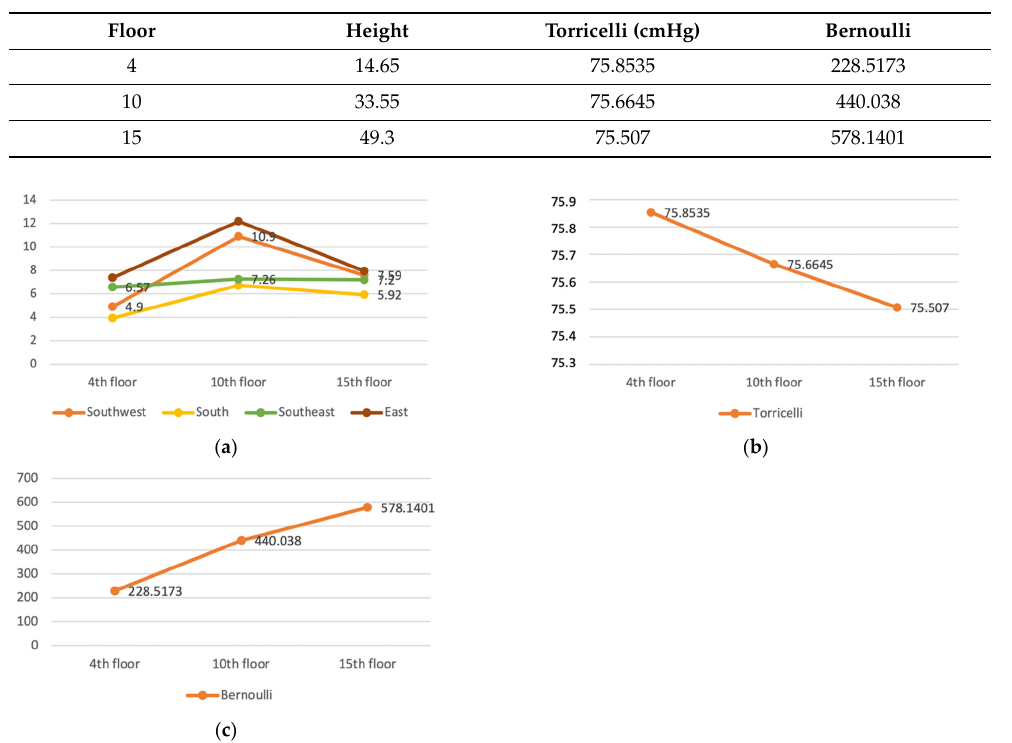
Figure 9. Comparison of the field calculations and measurements: ( a ) Air velocity from the field measurement; ( b ) Torricelli equation; and ( c ) Bernoulli equation.